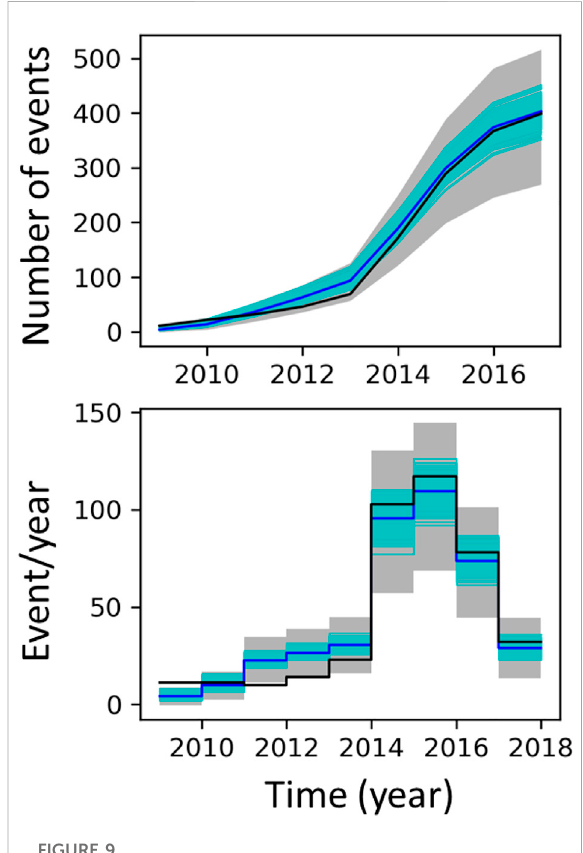
Comparison of the predicted seismicity histories with the data (black line). The model correspondsto 300 realizations (cyan) randomly drawn from the posterior density distribution obtained with the MCMC search during calibration. The mean of the models is indicated by the blue line. For each posterior member, 30 synthetic catalogues are generated in order to account for stochastic Poisson variabilities. The grey region indicates 95% of the distribution of the 9,000 synthetic catalogues when stochastic Poisson variabilities are accounted for. Top: cumulated number of events. Bottom: yearly event